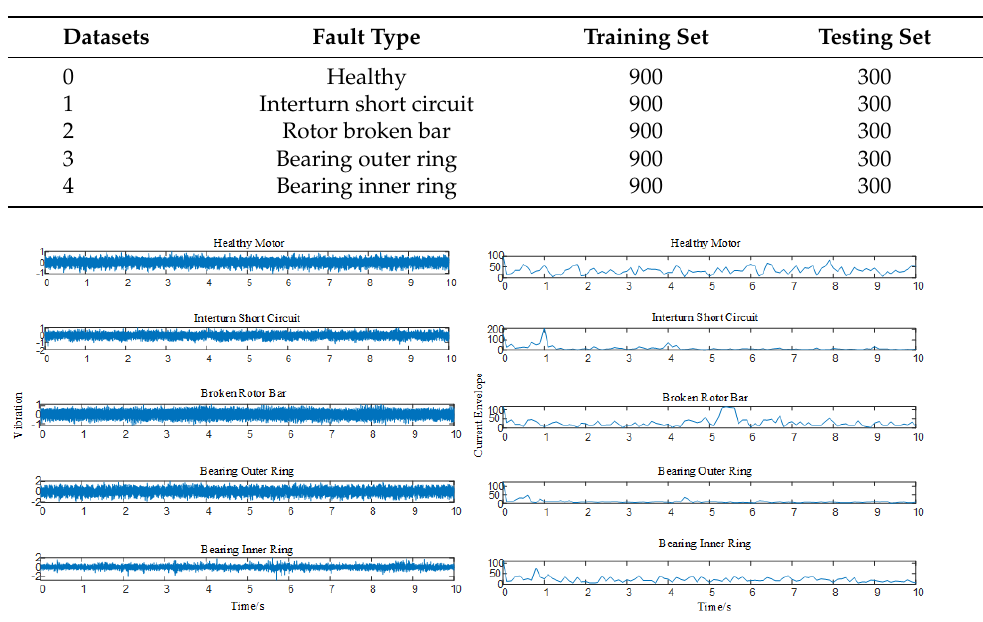
Figure 8. Fault simulation. Table 3. Motor fault data set.